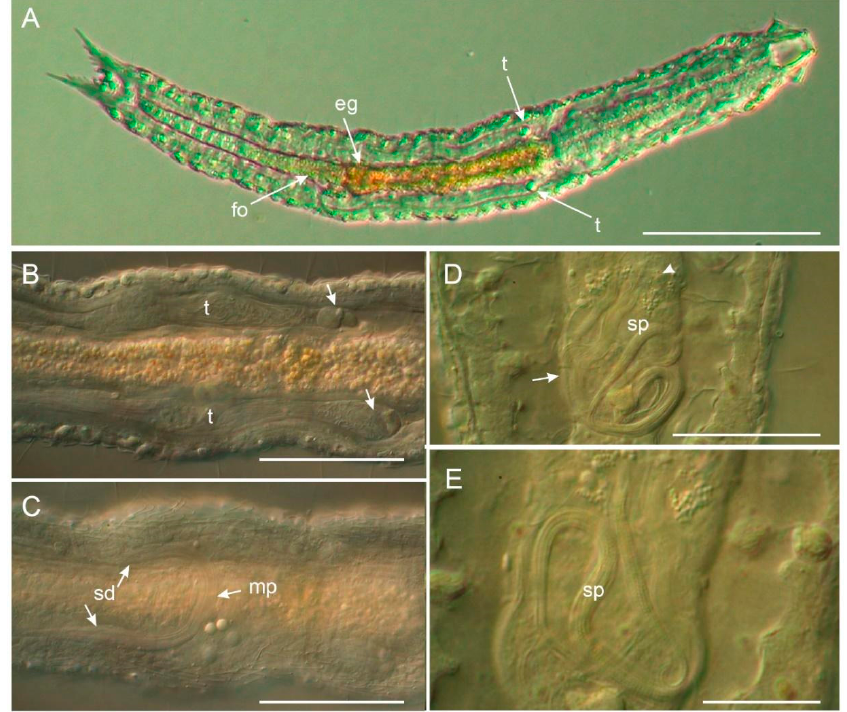
Figure 5. Adult specimen of Paraturbanella tricaudata sp. nov. (2002–2003 sampling). ( A ) Habitus, indicating the anterior most portion of the testes (t), frontal organ (fo) and the largest egg (egg). ( B ) Trunk region showing the testes (t), including the anterior most portion (arrows). ( C ) Trunk region from a slightly different focal plane showing the anastomosis of the sperm ducts (sd) and the ventral, ephemeral male pore (mp). ( D ) Dorsal view of the trunk region showing the frontal organ with a bundle of allosperm inside; the arrowhead indicates the location of the dorsal external pore through which sperm (sp) have been injected. ( E ) Close-up of the spermatozoa bundle inside the frontal organ. Scale bars: A = 100; B , C = 50; D , E = 20 µ